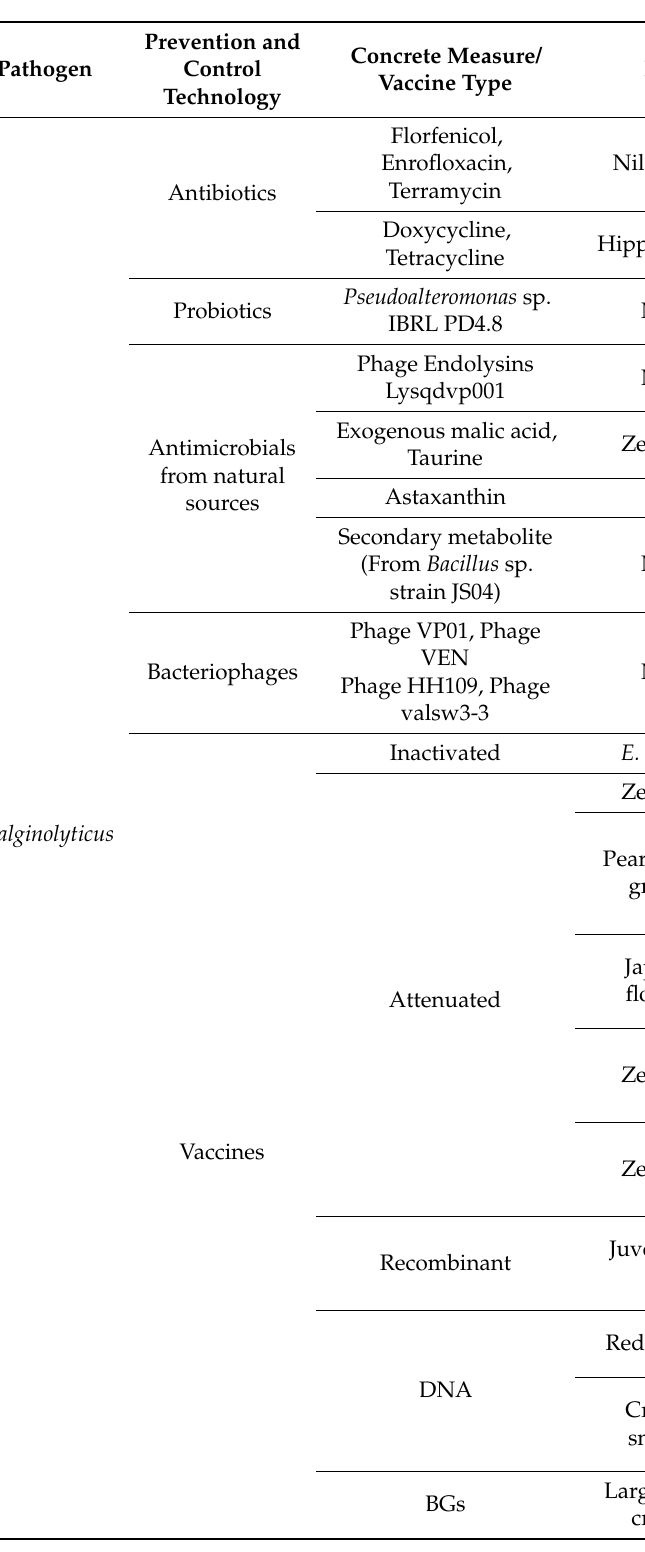
Table 7. Control and prevention strategies of V. alginolyticus. NR: Not Relevant, None: the method has not been tested in vivo or relevant data has not been